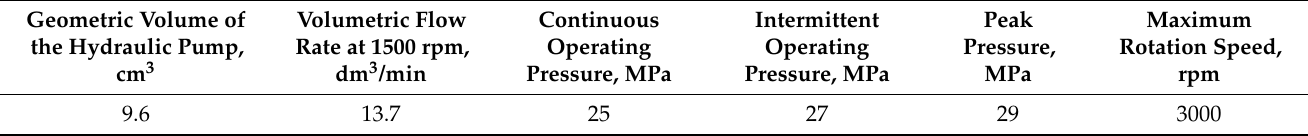
Table 2. Parameters of the Marzocchi ALPP2-D-13 hydraulic pump